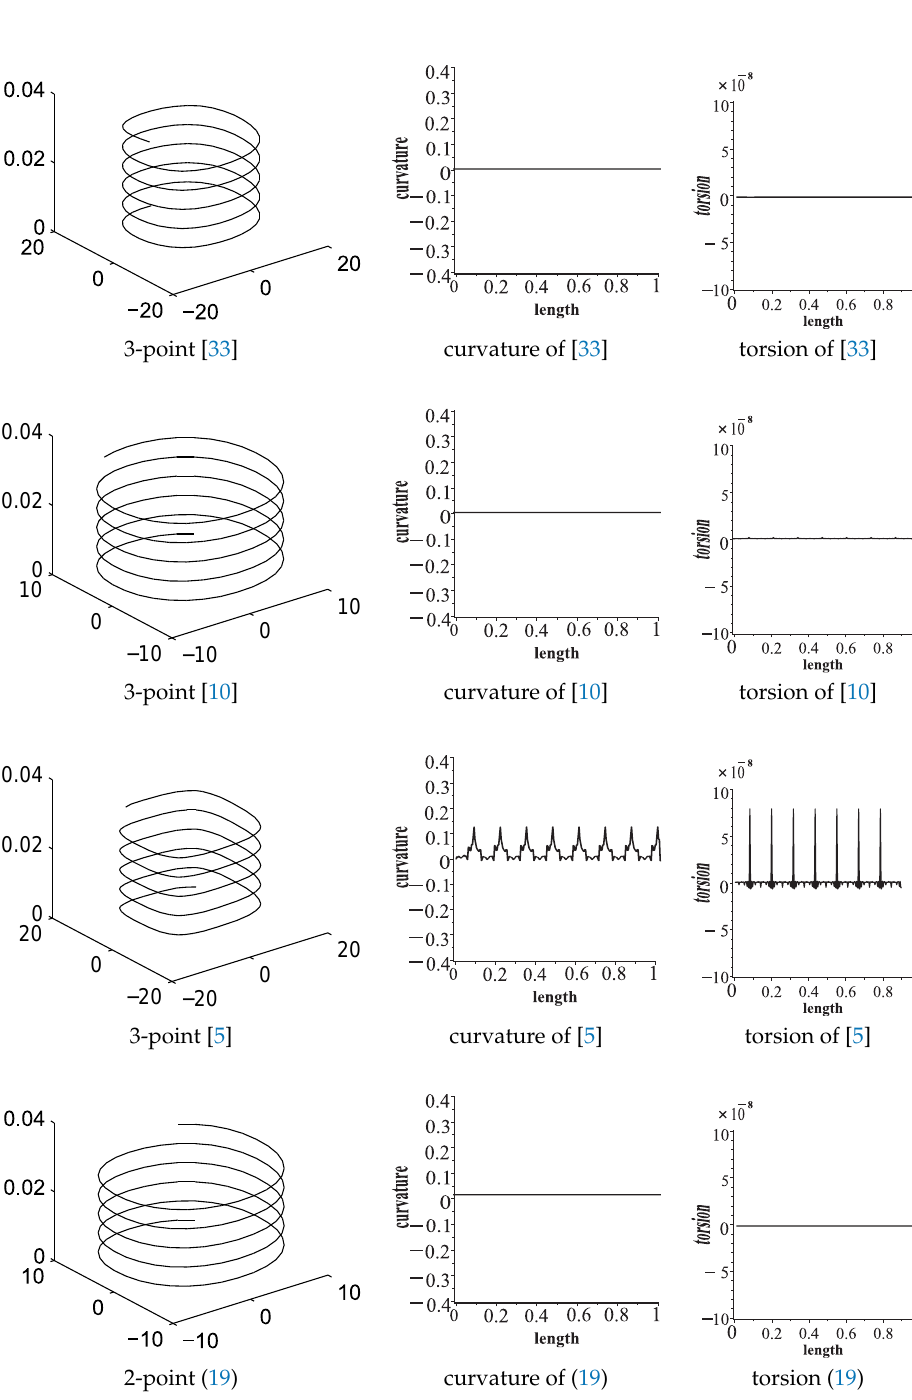
Figure 4. Results of 5th iteration of the 3-point schemes [5,10,33] and (19) are shown on the left when the initial control points are sampled from Helix. The corresponding curvatures and torsions are shown in the center and right column,